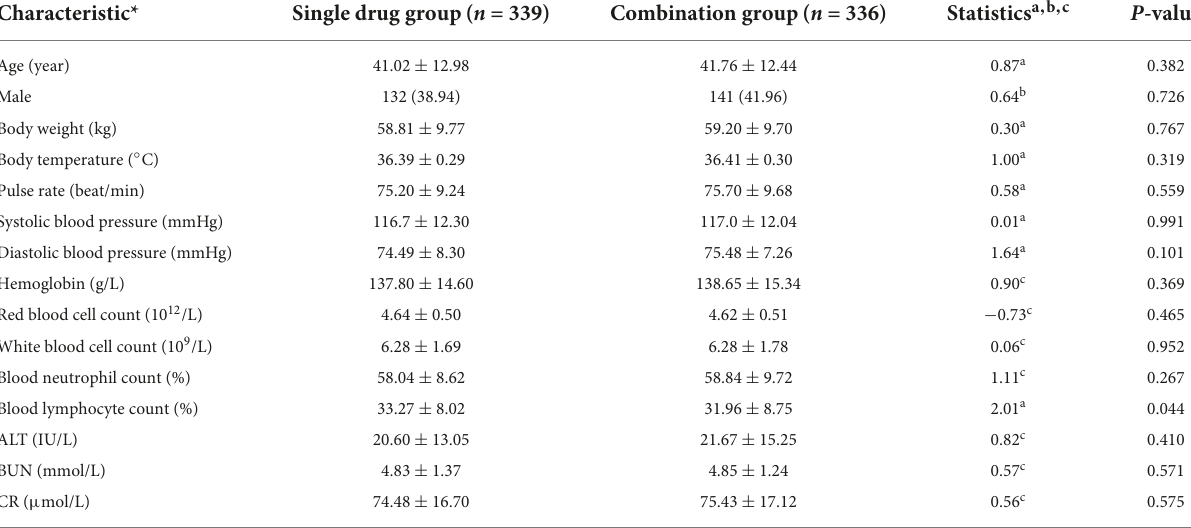
Characteristic* Single drug group ( n = 339) Combination group ( n = 336) Statistics a , b , c P